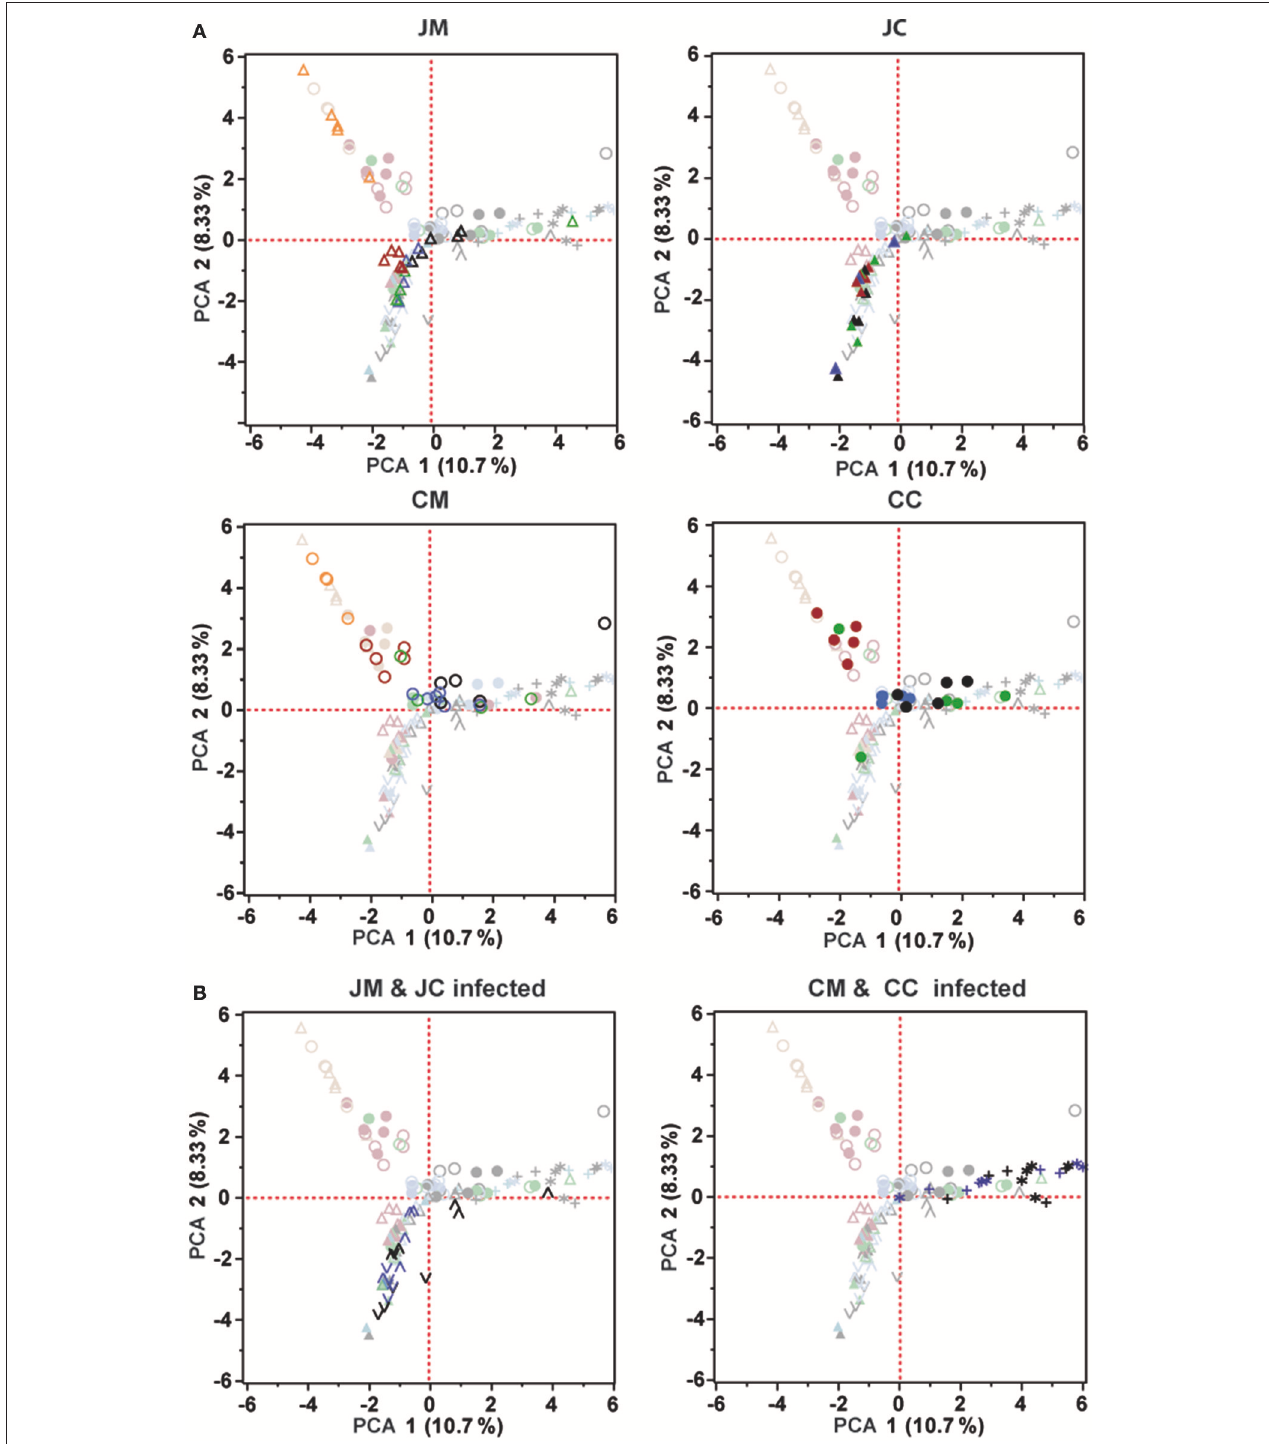
FIGURE 6 | Principal component analysis (PCA) was analyzed for the control (A) and infected birds (B) . Orange (day 1), Red (day 7), Green (day 14), Blue (day 21), and Black (day 28). Each symbol indicates an individual bird. All PCA plots include the data of all samples; symbols not belonging to the sample group indicated in the header are displayed faded. JM, jejunal mucosa; JC, jejunal content; CM, cecum mucosa; CC, cecum content.